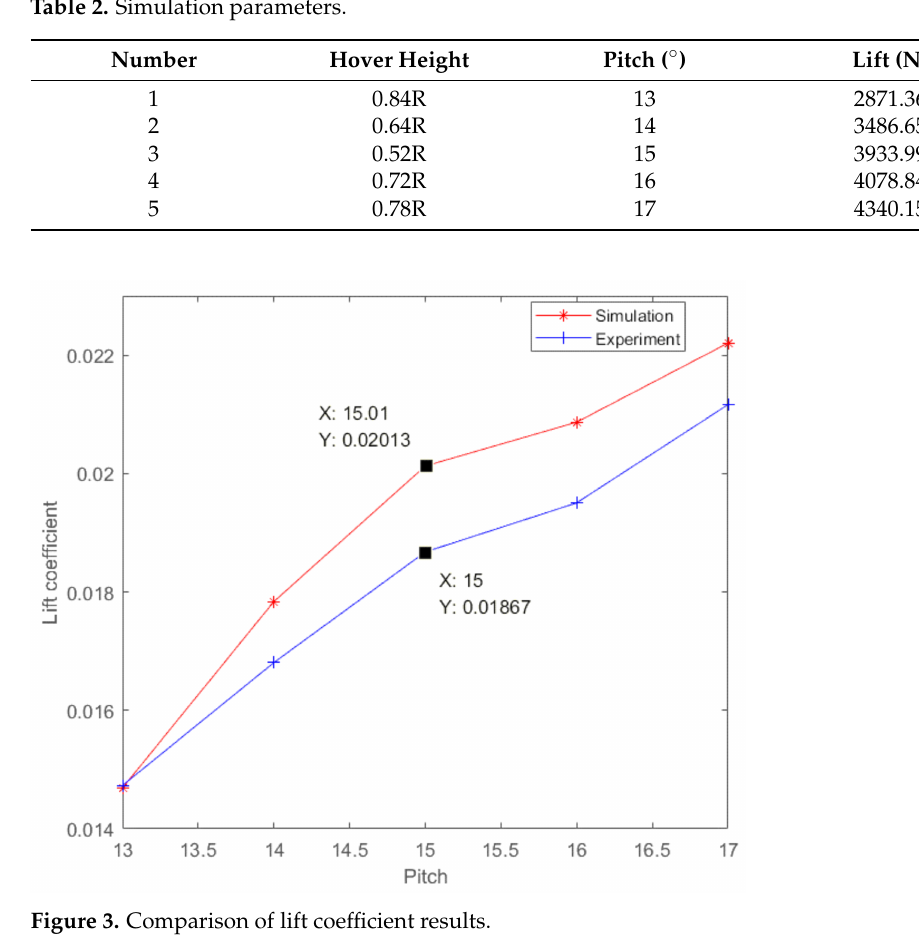
Figure 3. Comparison of lift coefficient